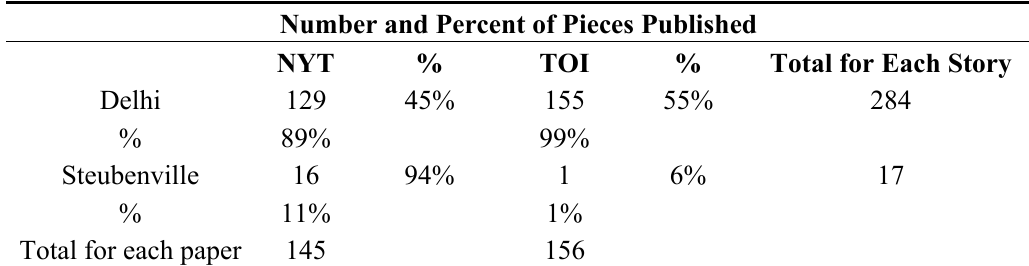
Table 1. Coverage of Each Case in NYT and